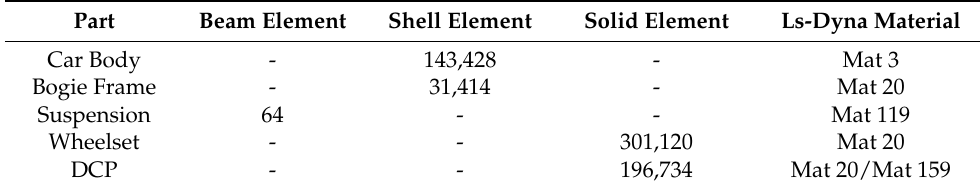
Table 3. The number of fi nite elements of the simulation model.